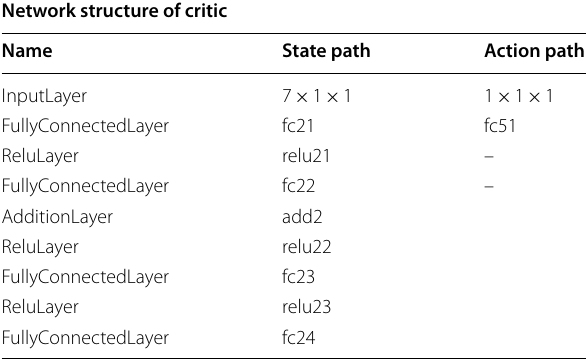
Table 3 Initial state for host vehicle and preceding